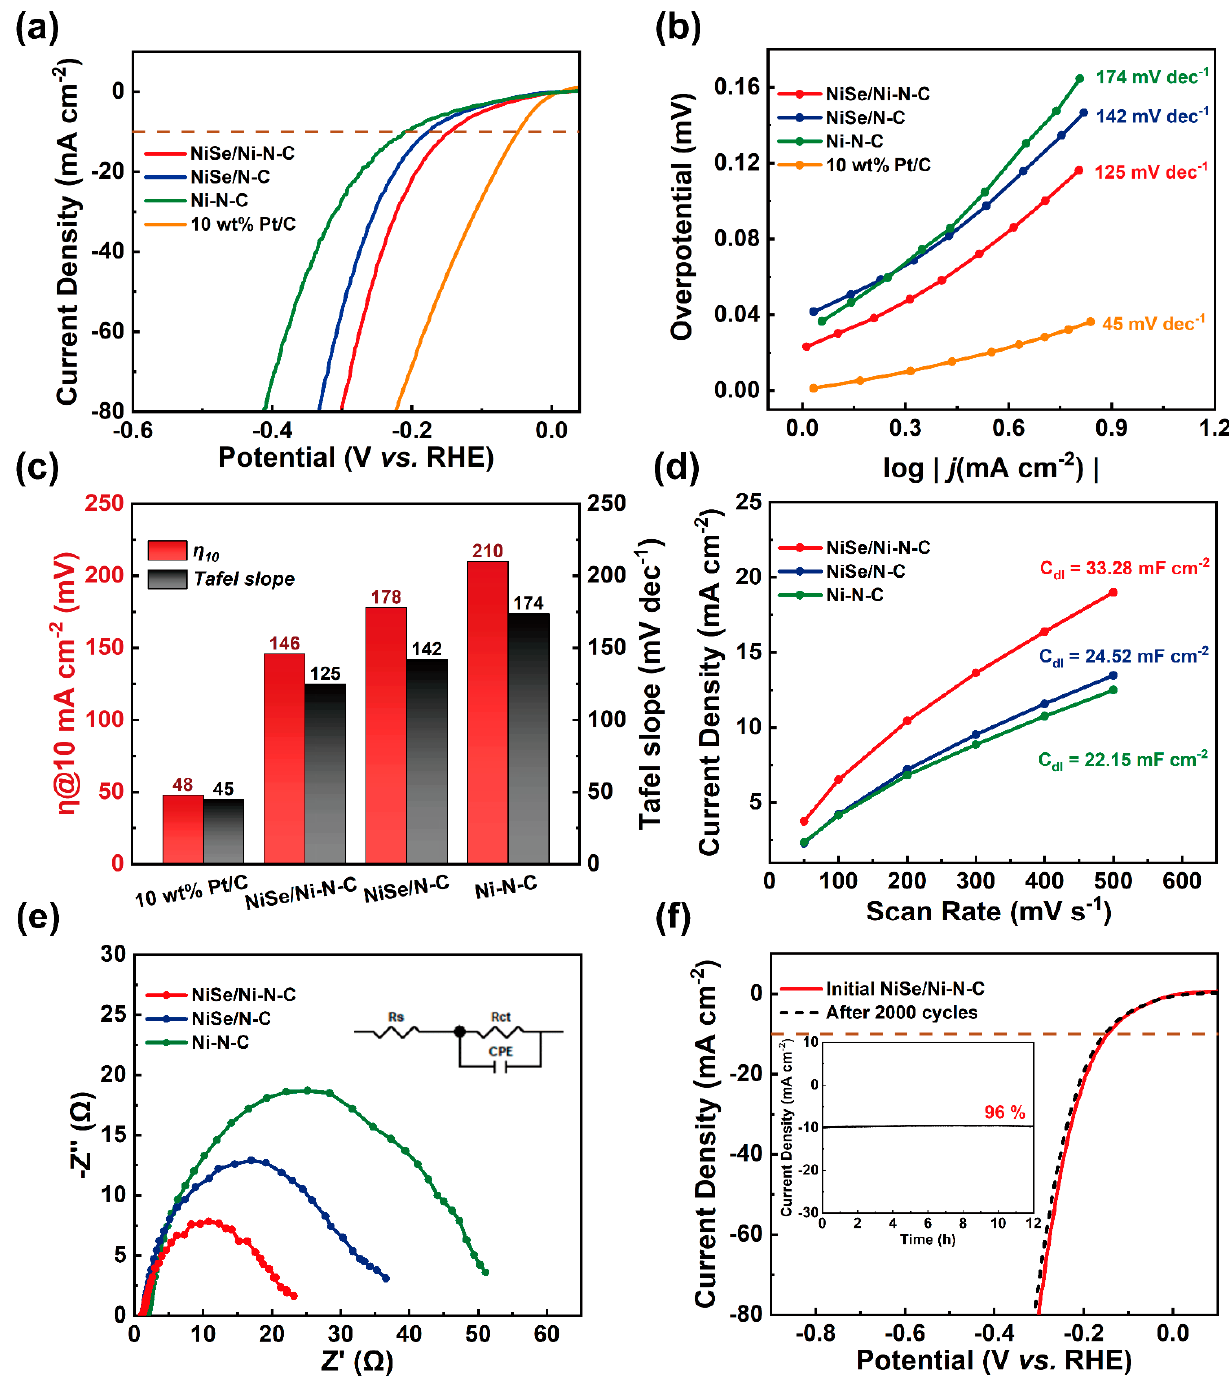
Figure 3. HER activity in 1.0 M KOH: ( a ), LSV polarization curves, ( b ) Tafel plots, ( c ) comparison of η 10 values and Tafel slopes, ( d ) capacitive current density as a function of scan rates, and ( e ) Nyquist plots of NiSe/Ni − N − C and control samples. ( f ) LSV polarization curves of NiSe/Ni − N − C before and after 2000 CV cycles. Inset: chronopotentiometry test of NiSe/Ni − N − C under a constant potential of 146 mV for more than 12 h.